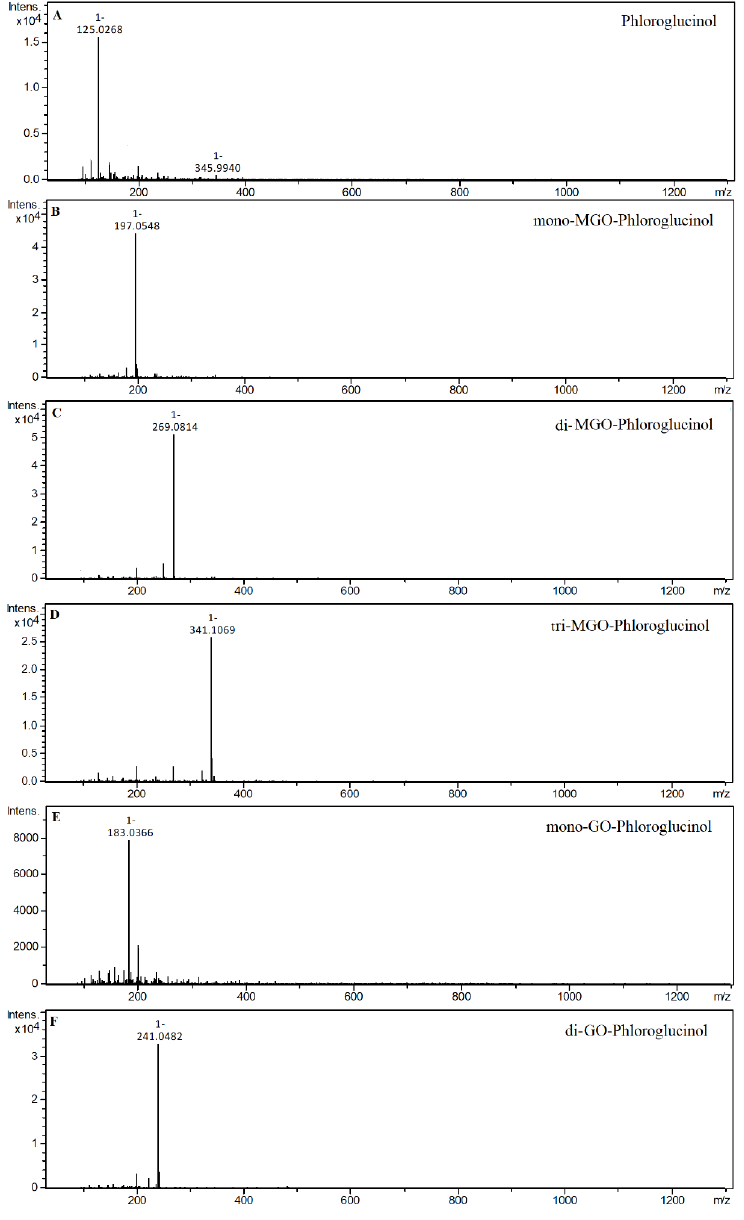
Figure 2. Mass spectra of phloroglucinol and its methylglyoxal/glyoxal adducts after 1 h of incubation in pH 7.4 phosphate buffer solution at 37 ◦ C; ( A ), phloroglucinol; ( B ), mono-MGO-phloroglucinol; ( C ), di-MGO-phloroglucinol; ( D ), tri-MGO-phloroglucinol; ( E ), mono-GO-phloroglucinol; ( F ), di-GO-phloroglucinol. Other isomers are also possible.